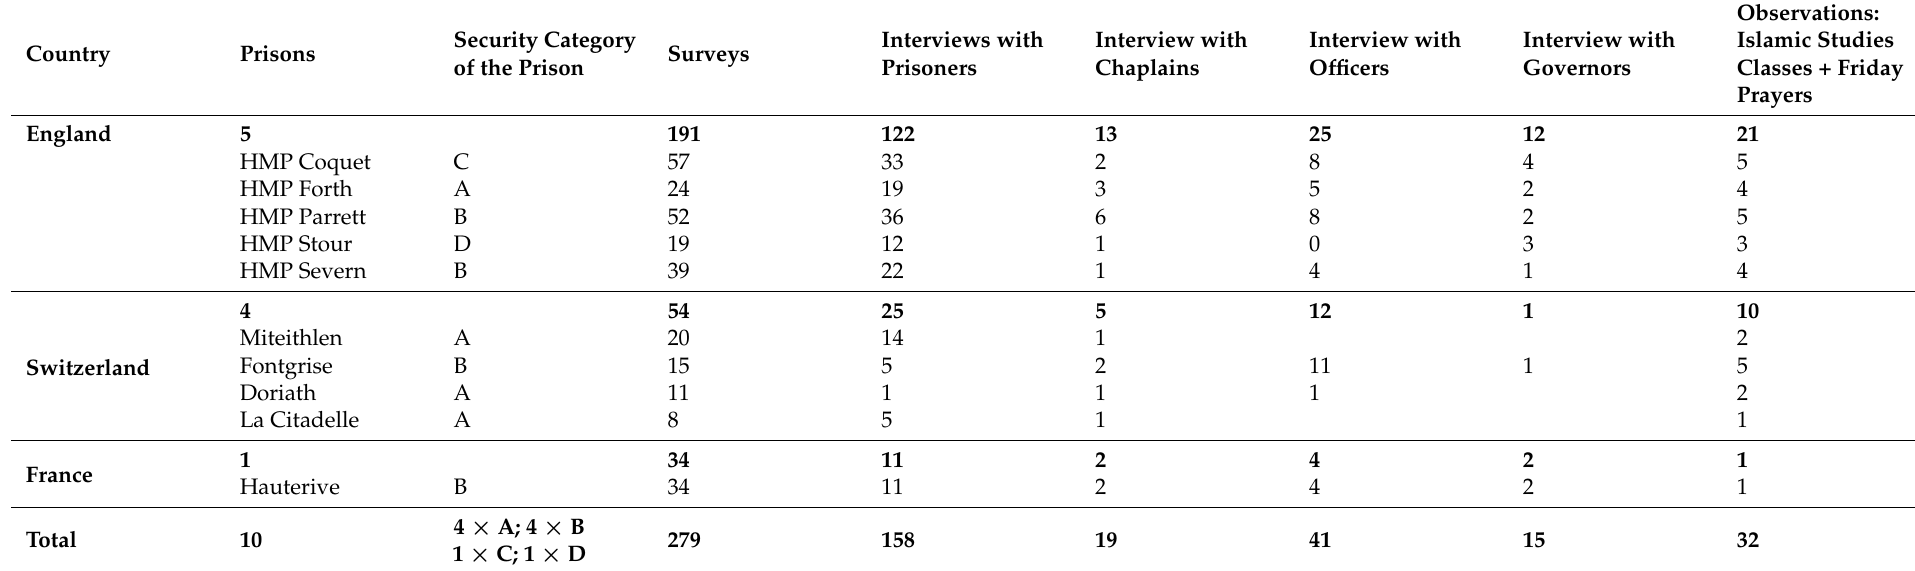
Table 1. UCIP research prisons and sample by jurisdiction (all names of research prisons and participants are